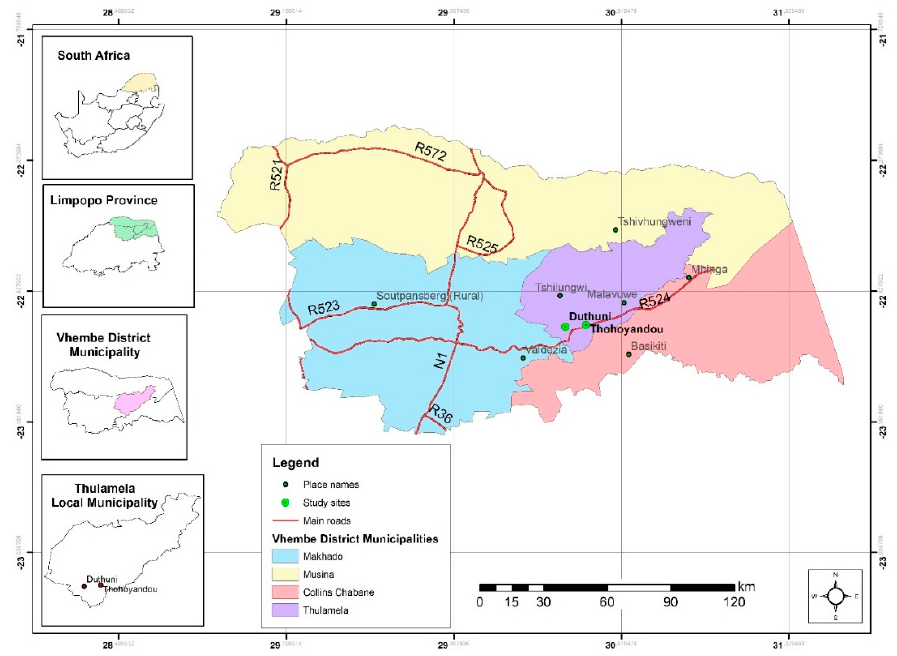
Figure 1. Location of Thohoyandou and Duthuni village in Thulamela municipality, both of which fall under the Vhembe district in Limpopo Province.